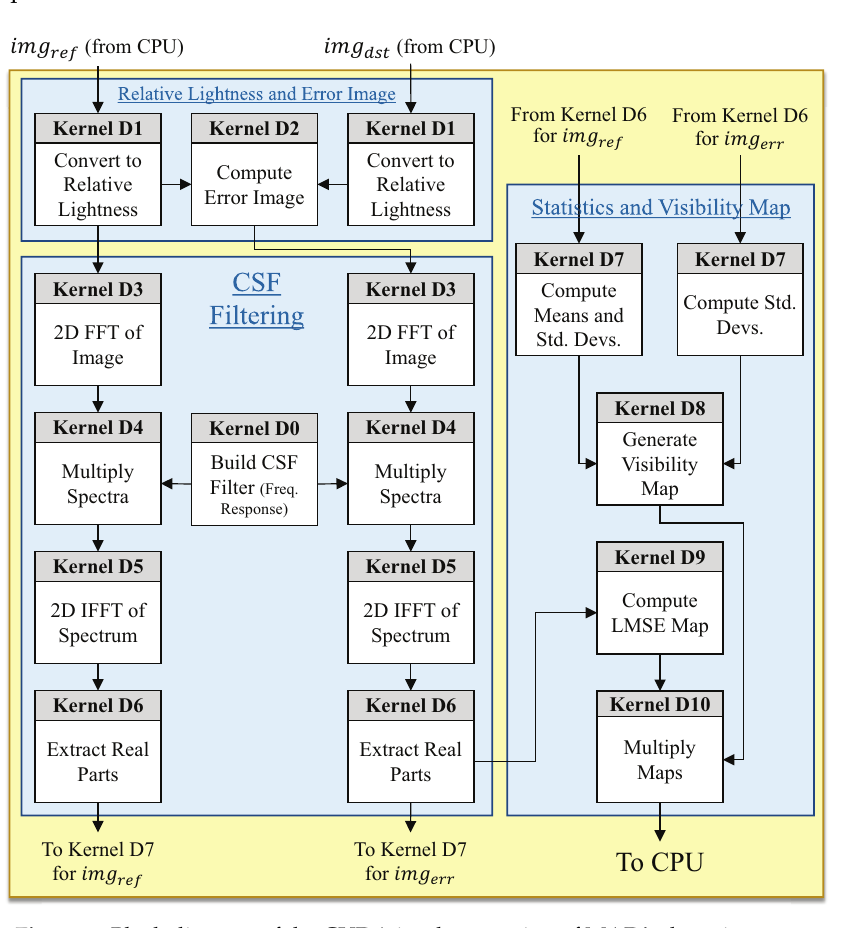
Figure 2. Block diagram of the CUDA implementation of MAD’s detection